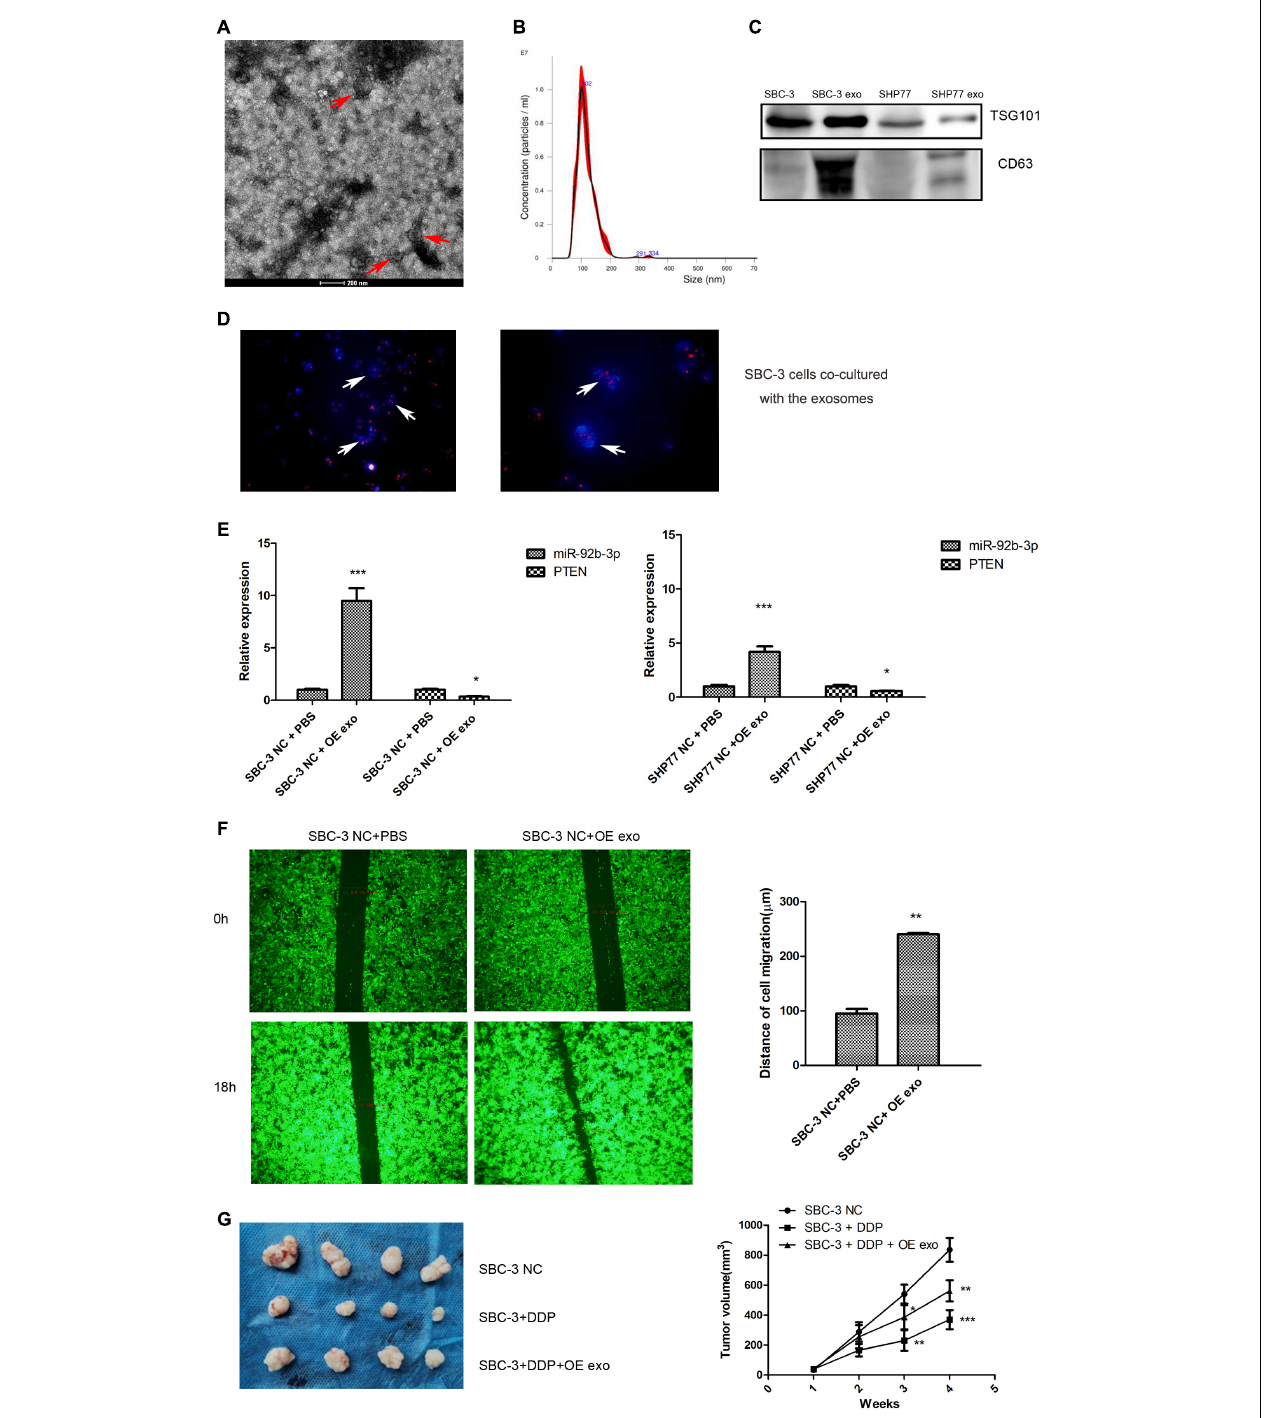
FIGURE 6 | Exosomes transfer miR-92b-3p to promote SCLC migration and chemoresistance. (A) TEM images of exosomes isolated from SCLC cells. (B) The size and quantitation of exosomes isolated from SCLC cells were examined by nanoparticle tracking analysis. (C) The levels of CD63 and TSG101 were detected by western blot. (D) Fluorescence microscopy images of SBC-3 cells after treatment with PKH26-labeled exosomes (green) stained with DAPI (blue). SBC-3 cells could effectively uptake the exosomes. (E) MiR-92b-3p and PTEN levels as detected by qRT-PCR. SCLC cells showed higher levels of miR-92b-3p and lower levels of PTEN after they were incubated with exosomes. (F) SCLC cells displayed higher migration ability after incubation with exosomes. (G) DDP treatment inhibited tumor growth, whereas this inhibition was reversed after combination therapy with exosomes. Compared with SBC-3 NC group, * P < 0.05, ** P < 0.01, and *** P < 0.001. All experiments were performed independently three times. SCLC, small cell lung cancer and TEM, transmission electron microscopy.